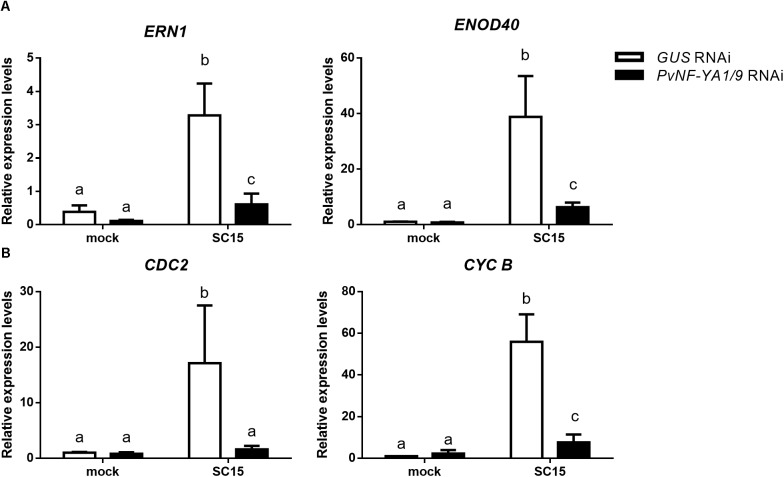
Rhizobial induction of early nodulins and cell cycle genes is compromised by silencing of PvNF-YA1/A9. Roots expressing GUS (white bars) or PvNF-YA1/9 RNAi (black bars) constructs were inoculated with the R. etli strain SC15 or mock inoculated with the media used to growth the rhizobia (mock). At 24 hpi, transcript levels of (A) nodulin and (B) cell cycle genes were determined by RT-qPCR. Values were normalized to PvEF1α and presented relative to the values of the mock-inoculated GUS RNAi roots. Error bars represent the SEM and different letters indicate that values are significantly different in a t-test with p < 0.05. Data are the average of three independent biological replicates, each performed with at least five independent plants.